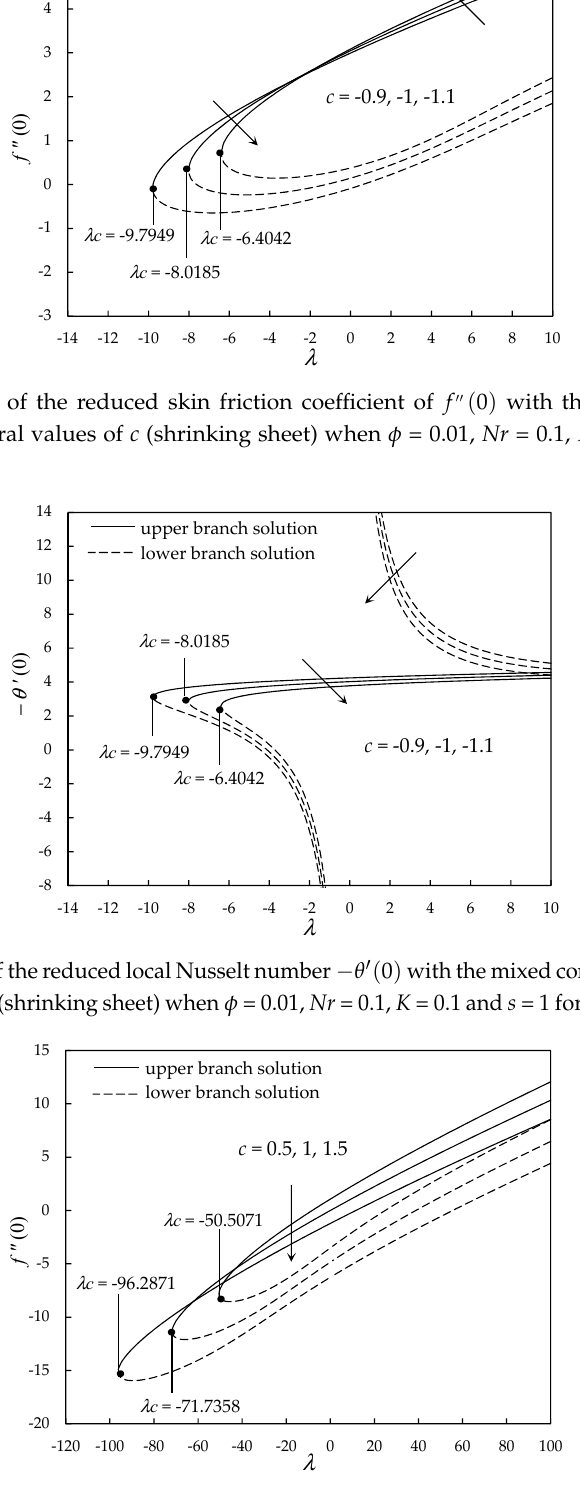
Figure 12. Variation of the reduced skin friction coefficient of f (cid:48)(cid:48) ( 0 ) with the mixed convection parameter λ for several values of c (stretching sheet) when φ = 0.01, Nr = 0.1, K = 0.1 and s = 1 for Cu-water nanofluid.